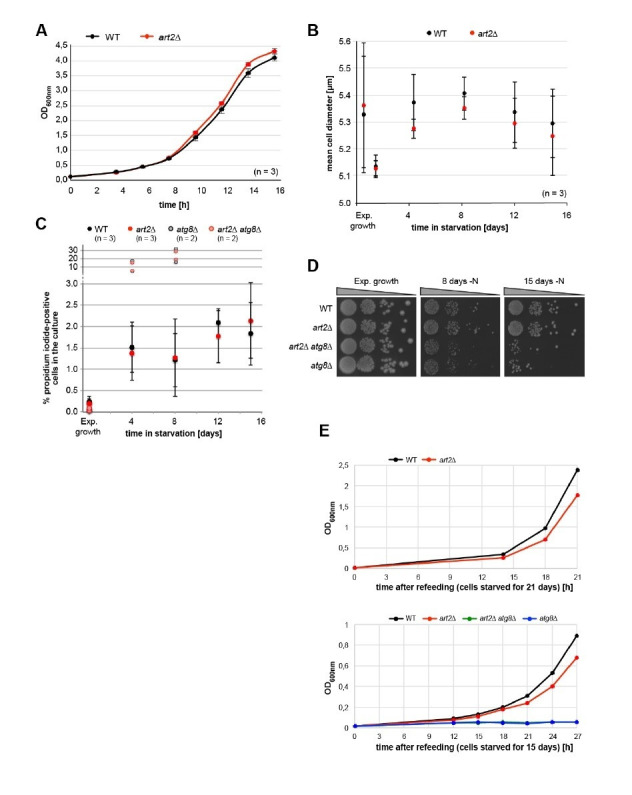
Physiological effects of ART2 deletion.(A) Growth of isogenic WT (art2Δ + pART2) and art2Δ cells in synthetic auxotrophy medium (YNB) at 26°C. Cultures were grown exponentially for 24 hours and then inoculated to OD600nm = 0.1 at t=0h. Culture density was followed by OD600nm. Mean ± standard deviation from n = 3 independent experiments. (B) Mean cell diameter (± standard deviation) measured with CASY TTT cell counter (Omni Life Sciences, Bremen, Germany) of isogenic WT (art2Δ + pART2) and art2Δ cells grown exponentially for >24 hours and then starved for amino acids and nitrogen for the indicated time. (C) Isogenic WT (art2Δ + pART2), art2Δ, atg8Δ (art2Δ, atg8Δ + pART2) and art2Δatg8Δ cells grown exponentially for >24 hours and then starved for amino acids and nitrogen for the indicated time. Cells were stained with propidium iodide (PI, 3 μg/ml) for ten minutes, washed, and PI-positive cells were counted on an Attune TM NxT Cytometer (Life Technologies). 50000 cells were counted for each genotype and replicate. WT and art2Δ: mean ± standard deviation from n = 3 independent experiments. For the atg8Δ and art2Δatg8Δ cells two independent experiments are shown. (D) Isogenic WT (art2Δ + pART2), art2Δ, atg8Δ (art2Δatg8Δ + pART2) and art2Δatg8Δ cells were grown exponentially for >24 hours and then starved for amino acids and nitrogen (-N) for the indicated time. Survival was assessed by colony forming ability. Serial dilutions of the cultures were spotted on YPD rich medium. (E) Isogenic WT (art2Δ + pART2), art2Δ, atg8Δ (art2Δatg8Δ + pART2) and art2Δatg8Δ cells were grown exponentially for >24 hours and then starved for amino acids and nitrogen (-N) for 21 (upper panel) and 15 days (lower panel). Starved cells were re-inoculated into fresh auxotrophic selection medium (YNB) to OD600nm = 0.1 at t = 0h. Culture density was followed by OD600nm.